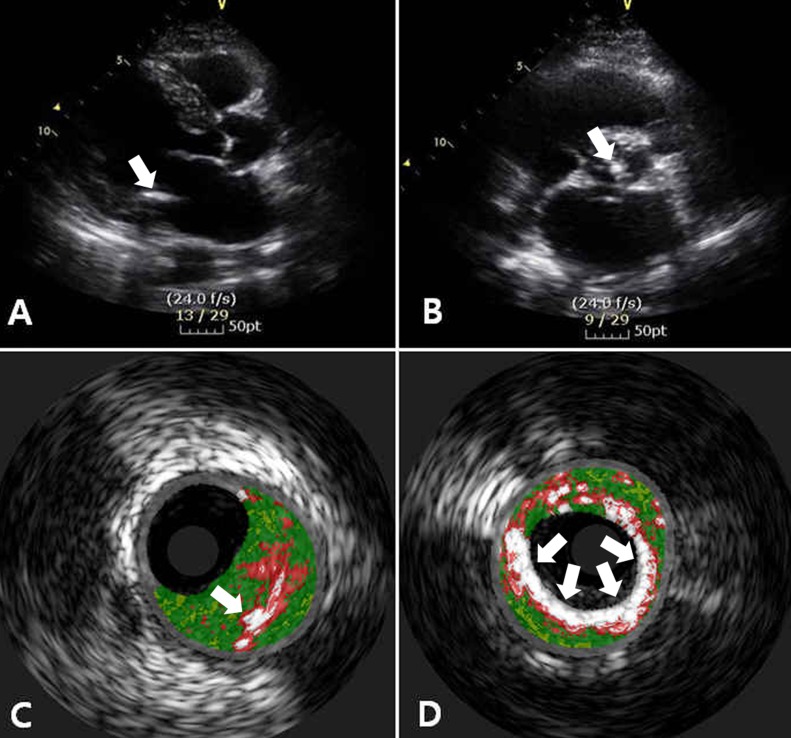
Representative images of valvular calcification and coronary artery calcification(white arrows).Transthoracic echocardiography showed mitral annular calcification (A) and aortic valve calcification (B). VH-IVUS demonstrated mild and severe coronary calcification. Mild valvular calcification revealed the prominent fibrous (green color) plaque components (C), while severe valvular calcification showed densely calcified plaque (D).